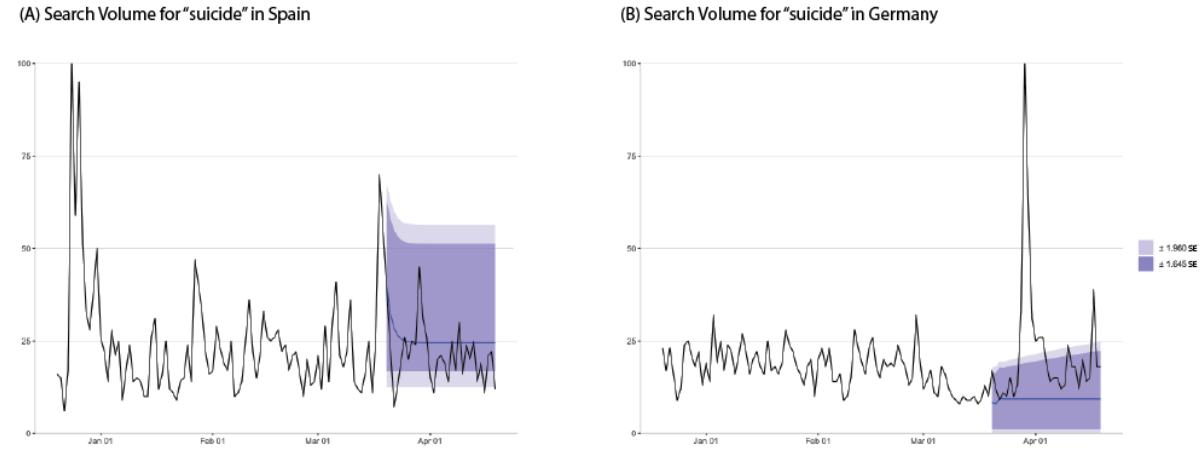
Figure 2. Daily trends for all Google searches with the term “suicide,” alongside expected trends for the days after March 20, 2020, in (A) Spain and (B)